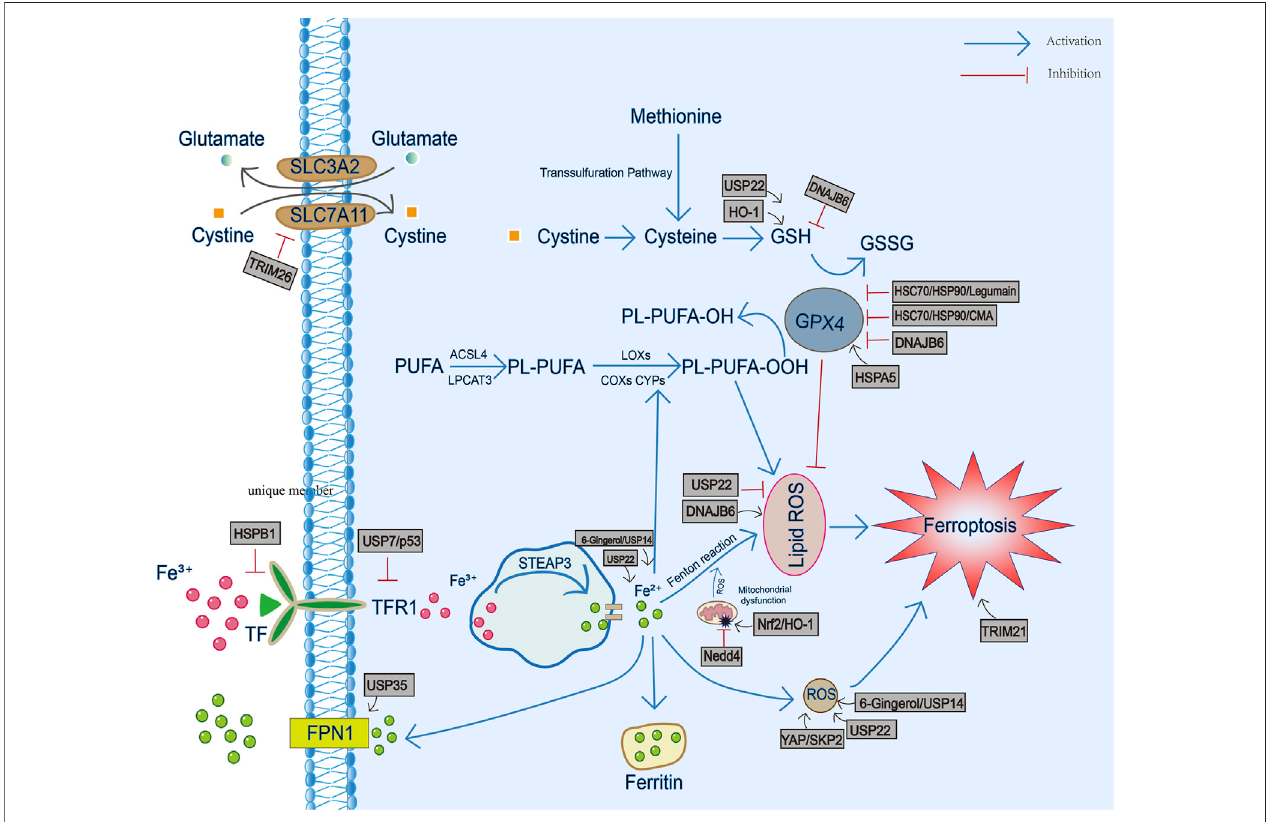
FIGURE 1 | The involvement of heat shock proteins in iron metabolism, GSH/GPX4 antioxidant pathway and production of reactive oxygen species and lipid peroxidation during ferroptosis. TF, transferrin; TFR1, transferrin receptor 1; FPN1, ferroportin1; PL-PUFA, phospholipid-bound polyunsaturated fatty acids; STEAP3, six-transmembrane epithelial antigen of prostate 3; ROS, reactive oxygen species; GSH, glutathione; GSSG, oxidized glutathione; GPX4, Glutathione peroxidase 4.